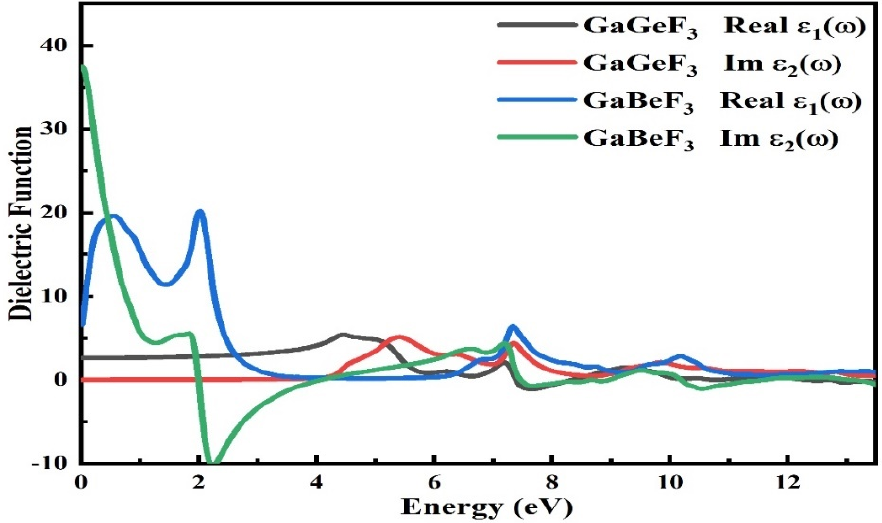
Figure 5. The calculated dielectric function ε ( ω ) for the GaMF 3 compound (M = Ge and Be). The Penn model predicts that GaGeF 3 has a ε 1 (0) value of 2.52, resulting in a large band gap of 5.131 eV, whereas GaBeF 3 has a band gap of 5 eV. Within the energy range of 14.0 eV, the calculated ε 2 ( ω ) (the second component) of ε ( ω ) is shown in Figure